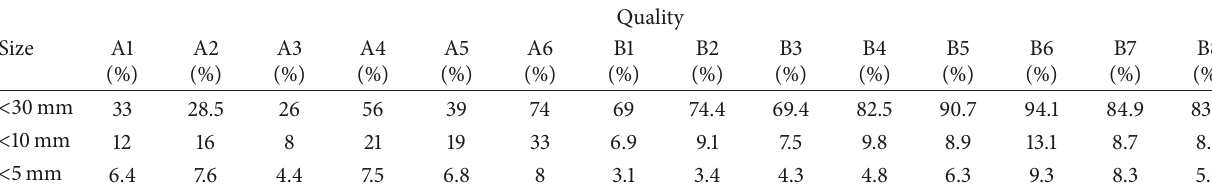
Table 5: Quality percentage and fragment sizes of specimens.